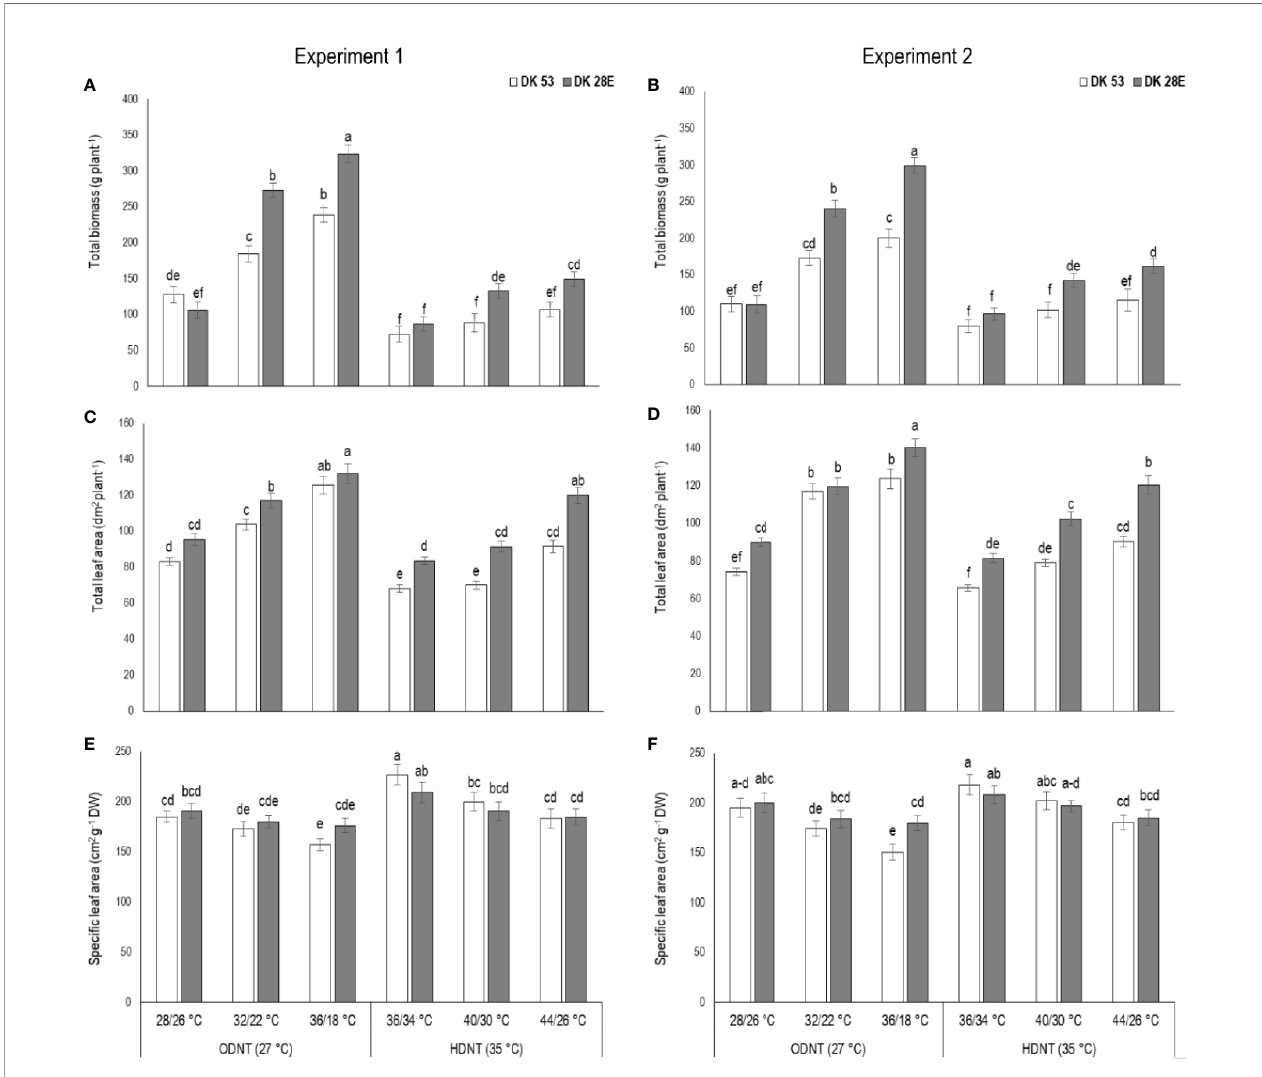
FIGURE 2 | Effect of two mean temperatures (27 and 35°C) [27°C (optimum mean daytime and nighttime temperature; ODNT) and 35°C(high mean daytime and nighttime temperature; HDNT)] with three diurnal temperature amplitudes (2, 10, and 18°C) on (A, B) total biomass (TB), (C, D) total leaf area (TLA) and (E, F) speci fi c leaf area (SLA) of two sorghum hybrids [DK 53 (white bar) and DK 28E (gray bar)]. Different letters in bar indicates signi fi cant difference according to Tukey ’ s HSD ( P <0.01; the test was conducted independently for each experiments). Each bar is mean value with standard error. Dry weight